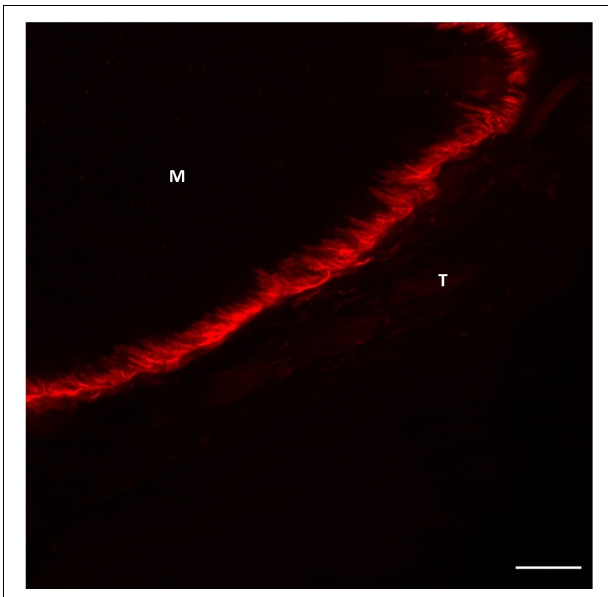
FIGURE 2 | Confocal image of human semitendinosus MTJ showing the highly folded muscle membrane at the interface between muscle (M) and tendon (T). Collagen XXII labeling (red) the foldings connecting the tendon (T) with the muscle (M) The nuclei are stained blue (DAPI). Scale bar is 10 µ m. For staining protocol and details regarding image acquisition (see Supplementary File